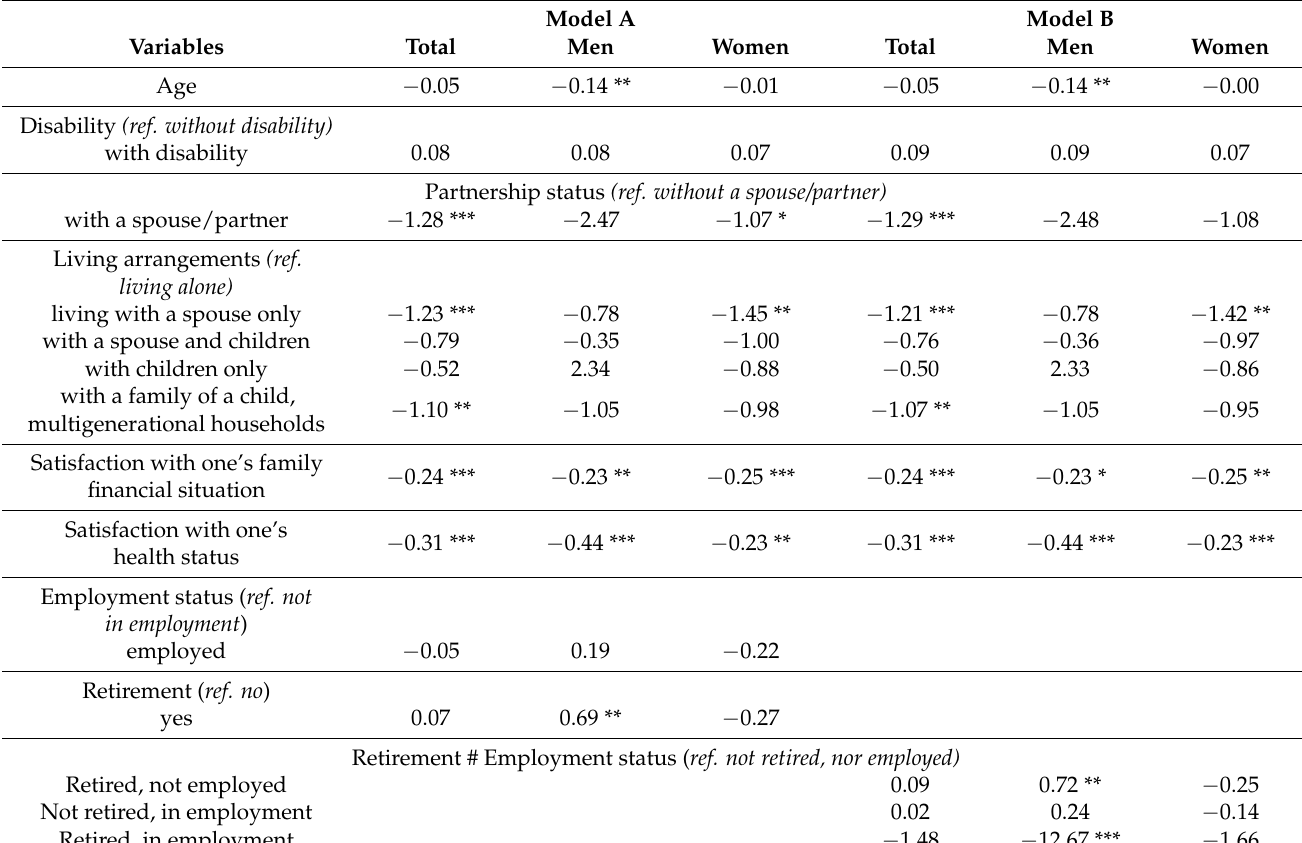
Table 2. Results of the fixed-effects logit models predicting loneliness among people aged 55–69 who retired in